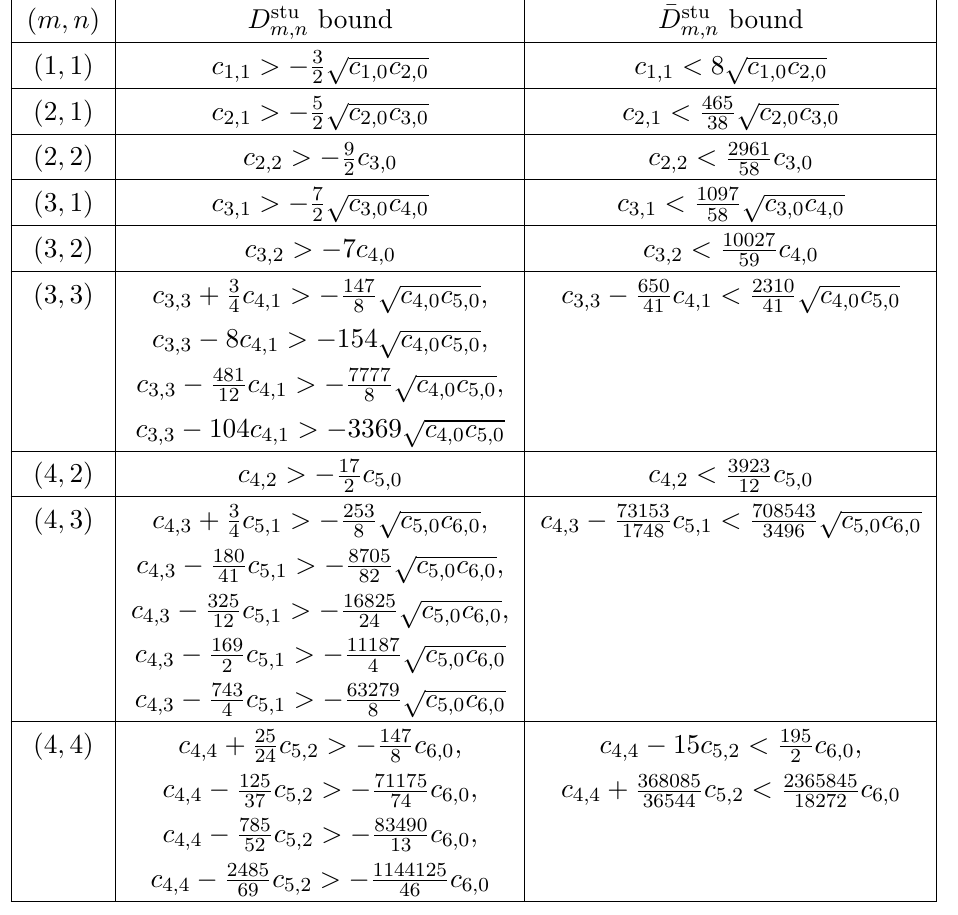
Table 2 . Explicit triple crossing positivity bounds in 4D up to level 1 /µ 10 . c m,n are the expansion coefficients of the pole subtracted amplitude in terms of w and t (see eq. (5.5)). These bounds are valid for weakly coupled UV completions where we choose σ = 1 (see eq.